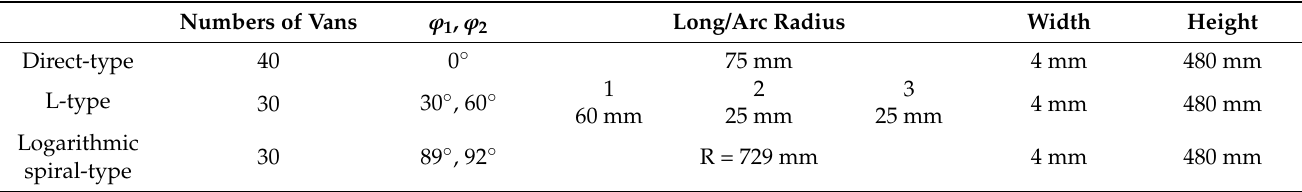
Table 1. Design of three different blade structural